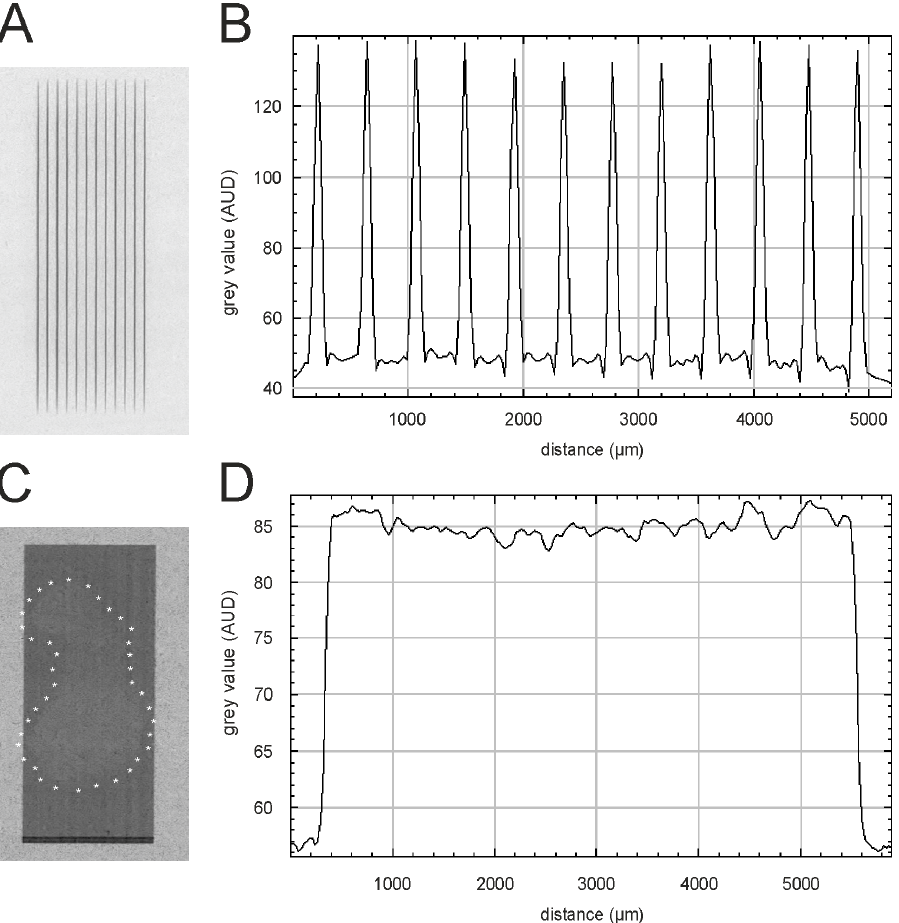
Figure 4. Dosimetry and visualization of the dose deposition in the esophageal segments. ( A , B ) Gafchromic™ HD-V2 film recorded during MBI of an esophagus sample and the corresponding beam profile. ( C , D ) The outline of the esophagus explant can be seen on the EBT3 Gafchromic™ film after BBI, and the white asterisks outline the sample edges. The corresponding profile of the broadbeam is shown in panel